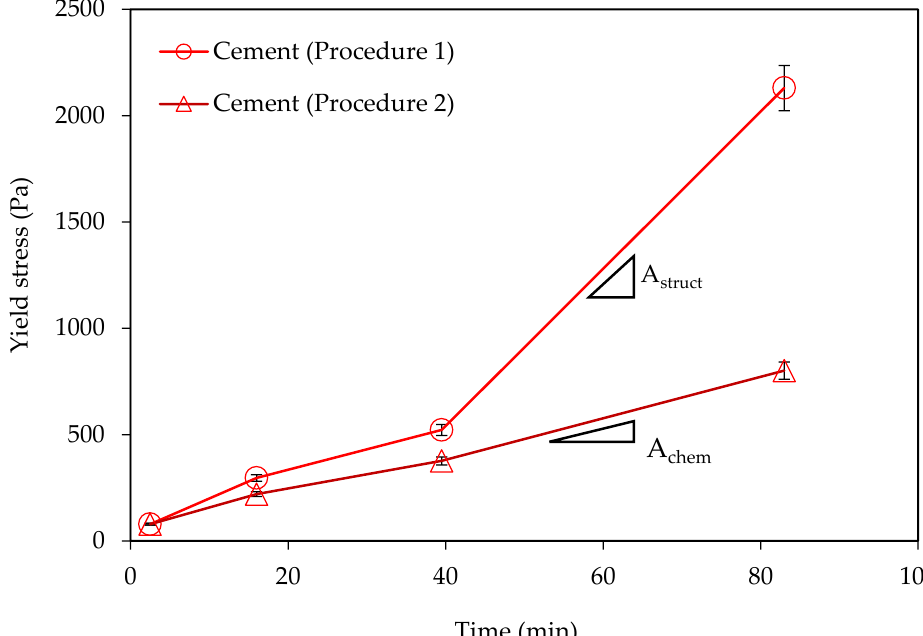
Figure 3. Evolution of the yield stress of the calcite suspension.